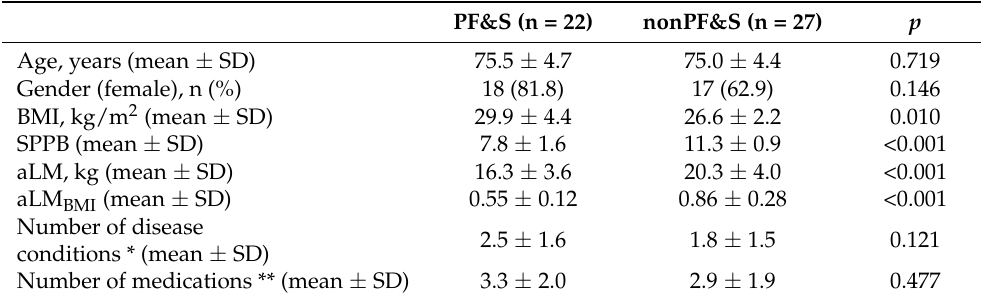
Table 1. Main characteristics of study participants according to the presence of physical frailty and sarcopenia (PF&S).